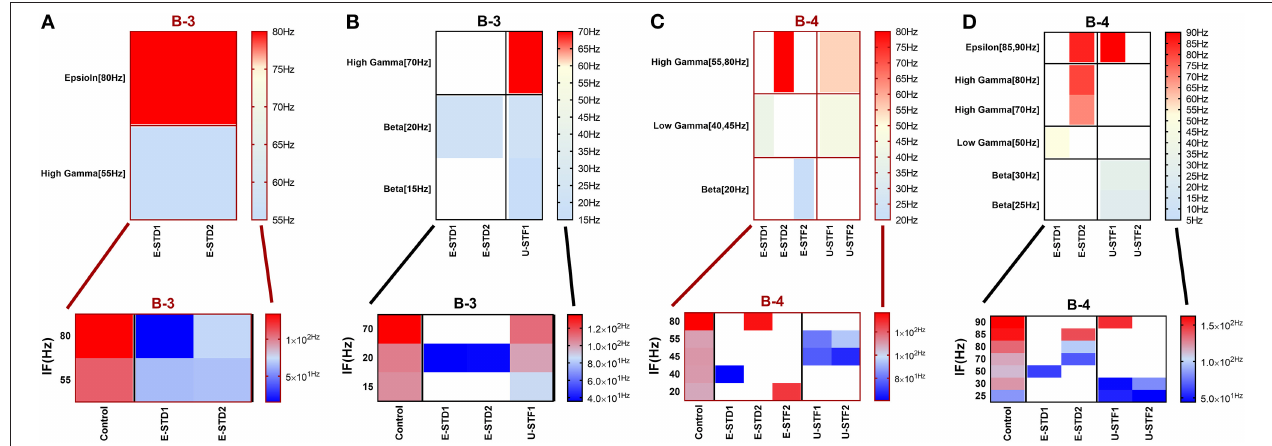
FIGURE 12 | Heat maps of selected elicited responses in each network scenario (B-3) and (B-4), in both immature and mature conditions, respectively, before and after implementing dynamical synapses. (A,C) refer to immature conditions of network scenarios (B-3 and B-4) while (B,D) relate to mature conditions of network scenarios (B-3 and B-4). The upper graphs refer to particular Poisson input frequencies [IF (Hz)] that triggered a substantial modulation effect, measured in Hz before and after STP in these networks (Lower graphs). White blocks refer to excluded values due to statistical variations in probability density function (PDF). Control refers to the condition without STP implementation (dynamical synapses); STD1 and STD2 refer to two types of depressing synapses while STF1 and STF2 refer to facilitating synapses. E-STD1, E-STD1, E-STF1, and E-STF2 relate to the expected modulation effect induced by dynamical synapses, i.e., reduction of firing rate activities in response to depressing synapses (STD1 and STD2) while increasing the firing rate activity in response to facilitating synapses (STF1 and STF2). On the other hand, U-STD1, U-STD1, U-STF1, and U-STF2 relate to the expected modulation effect induced by dynamical synapses, i.e., an increase of firing rate activities in response to depressing synapses (STD1 and STD2), while reduction in the firing rate activity in response to facilitating synapses (STF1 and STF2), see also Tables 5 , 6